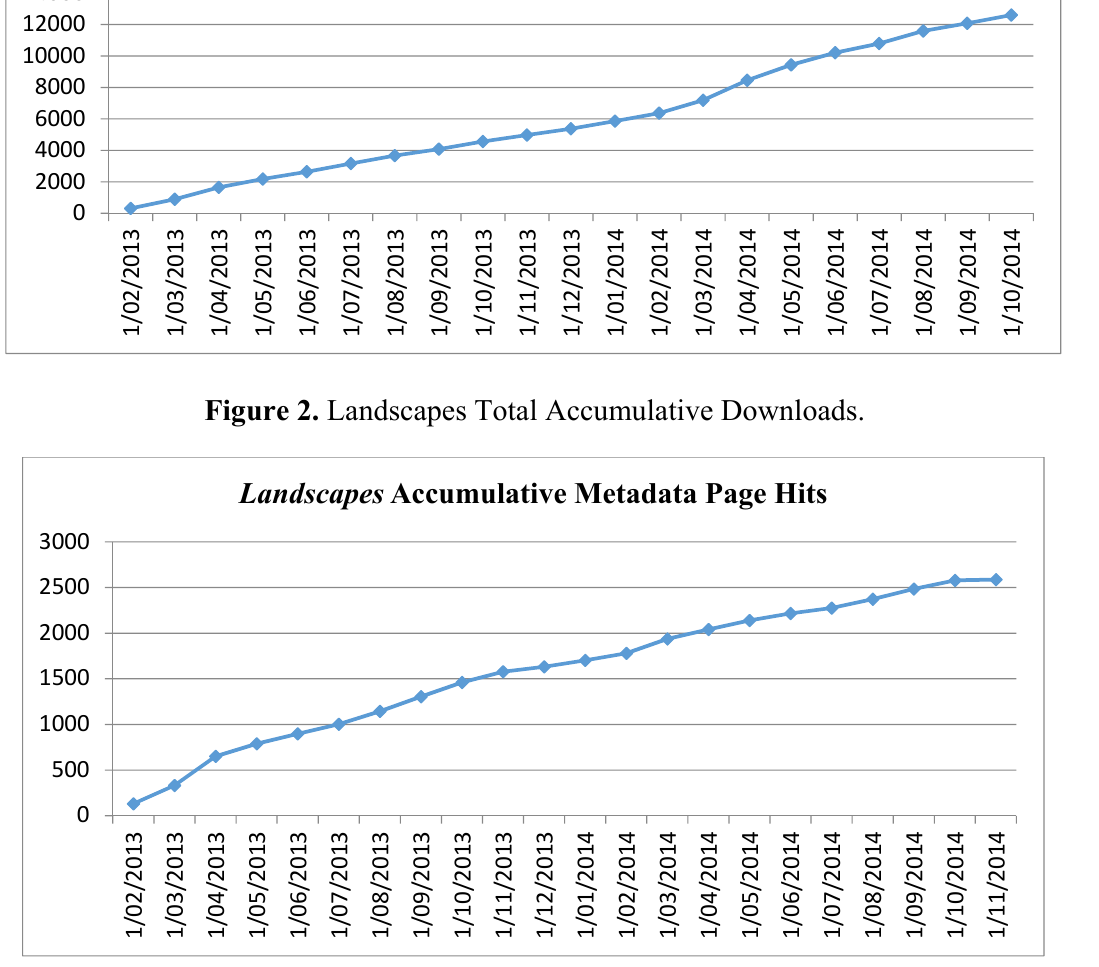
Figure 3. Landscapes Accumulative Metadata Page